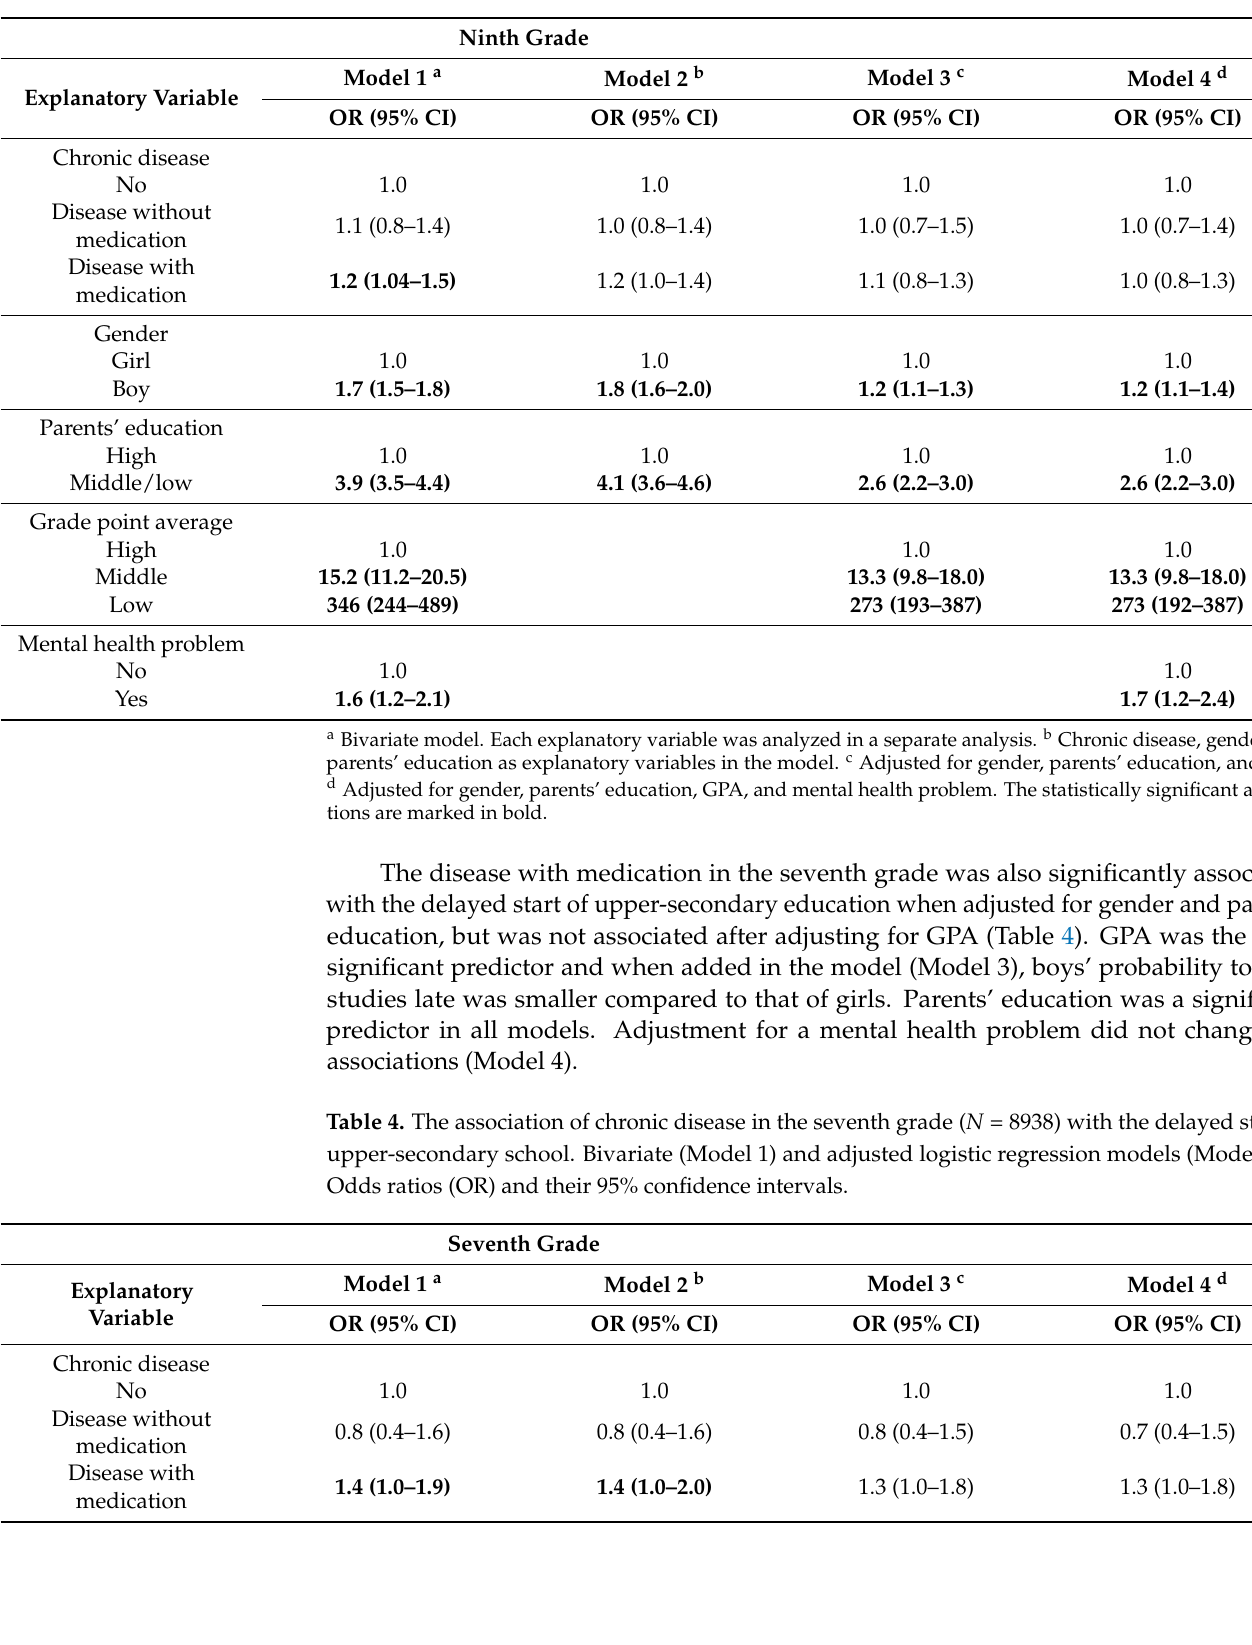
Table 3. The association of chronic disease in the ninth grade ( N = 7394) with ending up to the non-academic upper-secondary school. Bivariate (Model 1) and adjusted logistic regression models (Models 2–4). Odds ratios (OR) and their 95% confidence intervals.